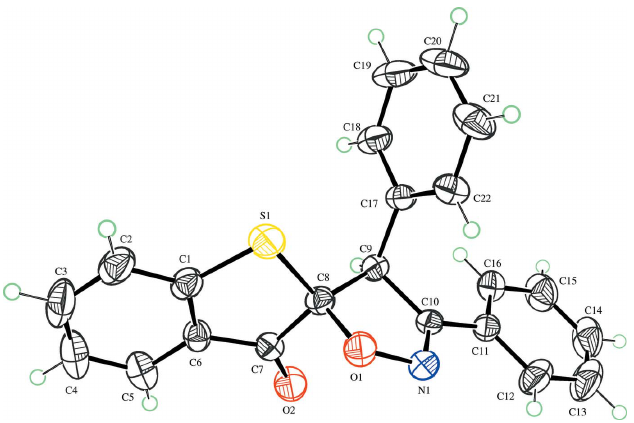
Figure 1 A plot of the molecule of the title compound with the atom-labelling scheme. Displacement ellipsoids are drawn at the 50% probability level. H atoms are represented as small